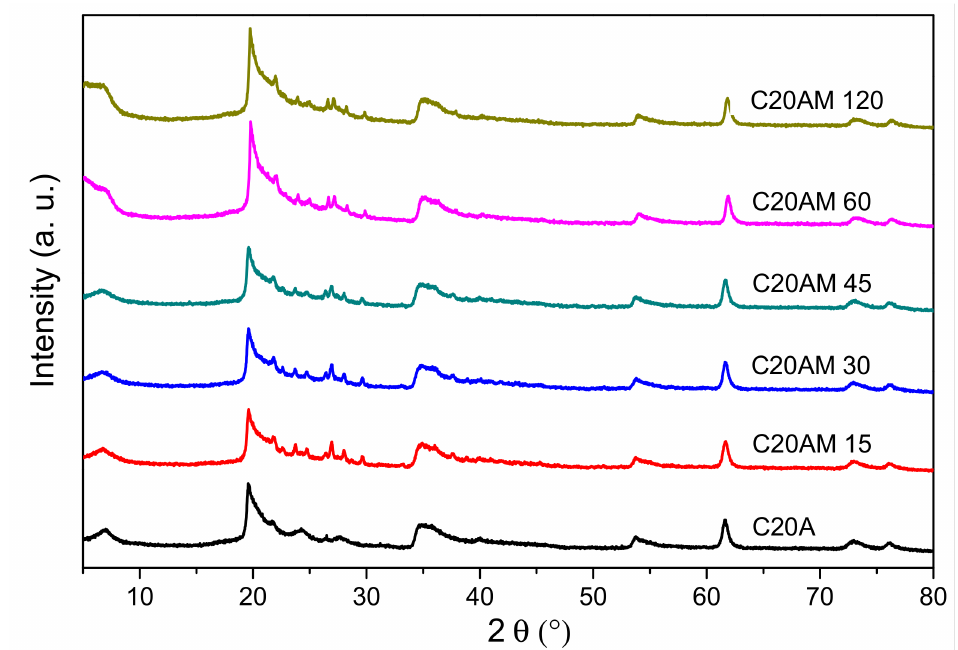
Figure 4. X-ray diffraction patterns of the unmodified nanoclay C20A and the modified nanoclay C20A with 1,4-diaminobutane